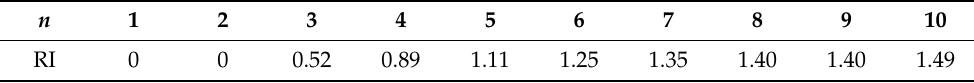
Table 2. Values of the Random Index (RI) for different n values